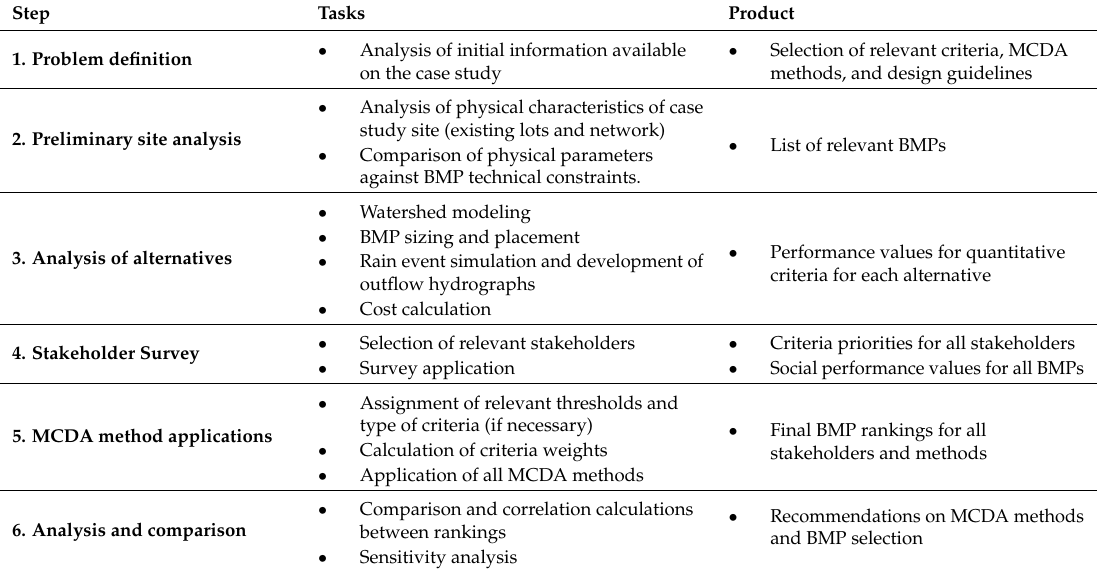
Table 3. Methodology step